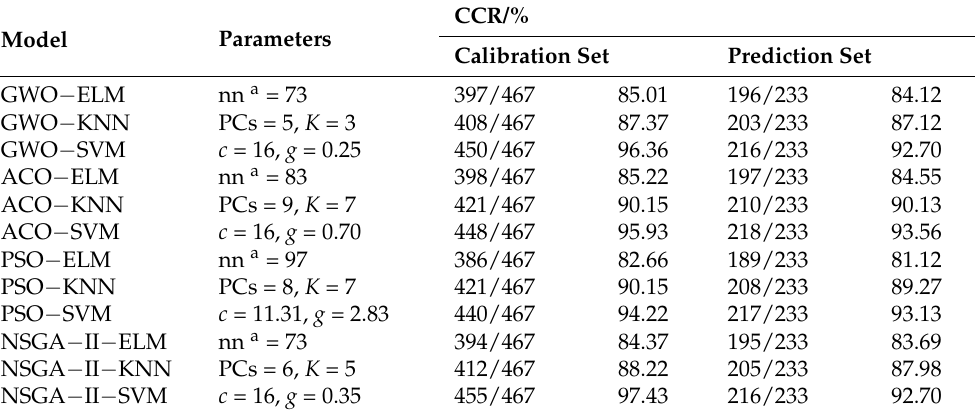
Table 3. Results of optimization models based on fused data and different chemometric